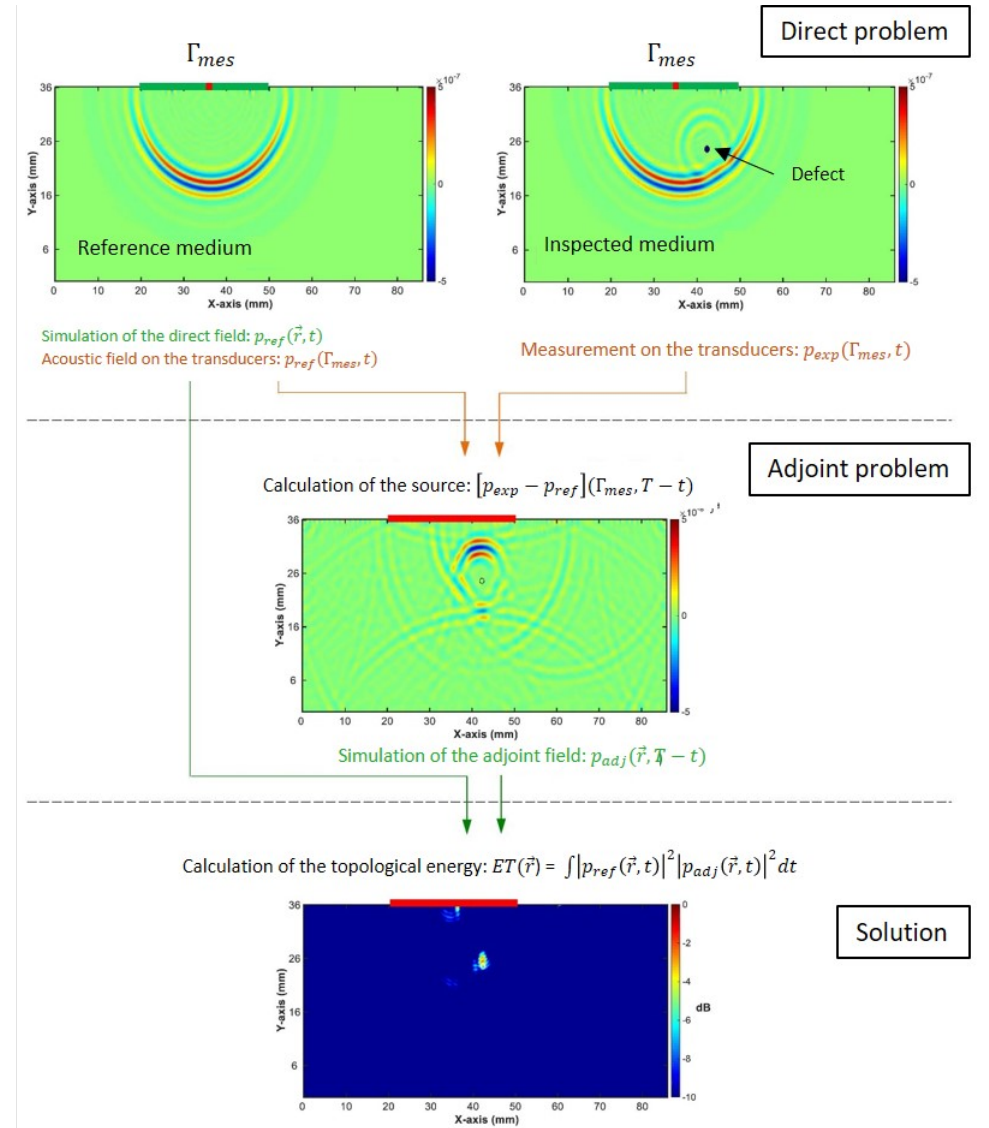
Figure 5. Diagram of the general principle of the topological imaging method in an isotropic medium [34]. Reproduced with permission from E. Lubeigt.